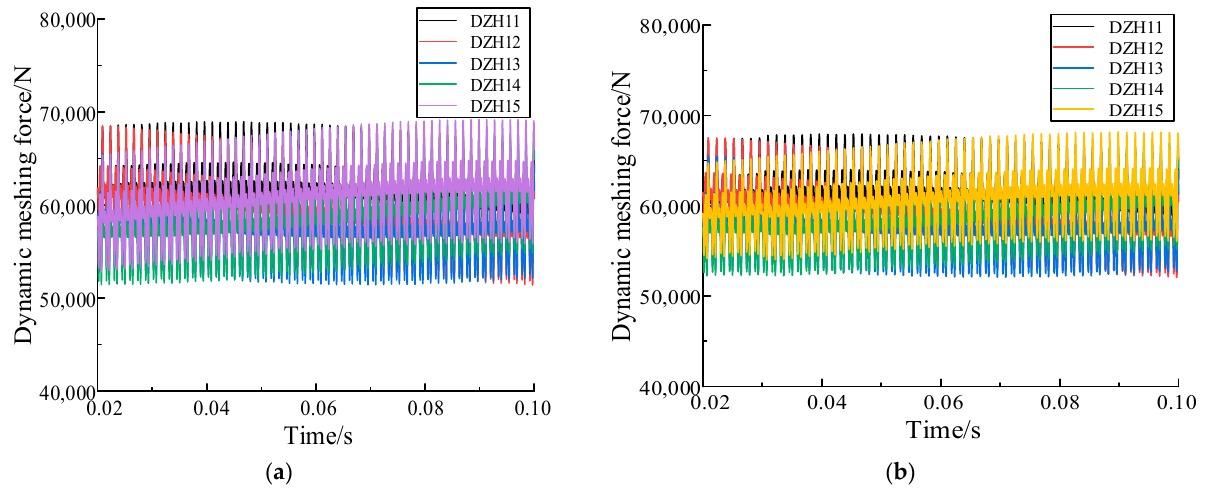
Figure 5. Dynamic meshing force with ring gear error. ( a ) Lumped mass method and ( b ) rigid cou- pling model.